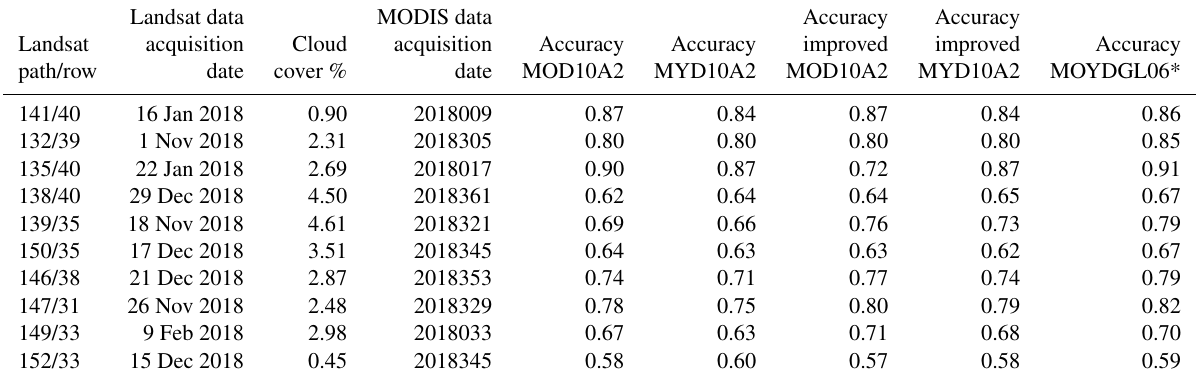
Table 1. Validation of snow cover (peak snow cover period) for 10 selected well-distributed areas to represent the study area derived by the